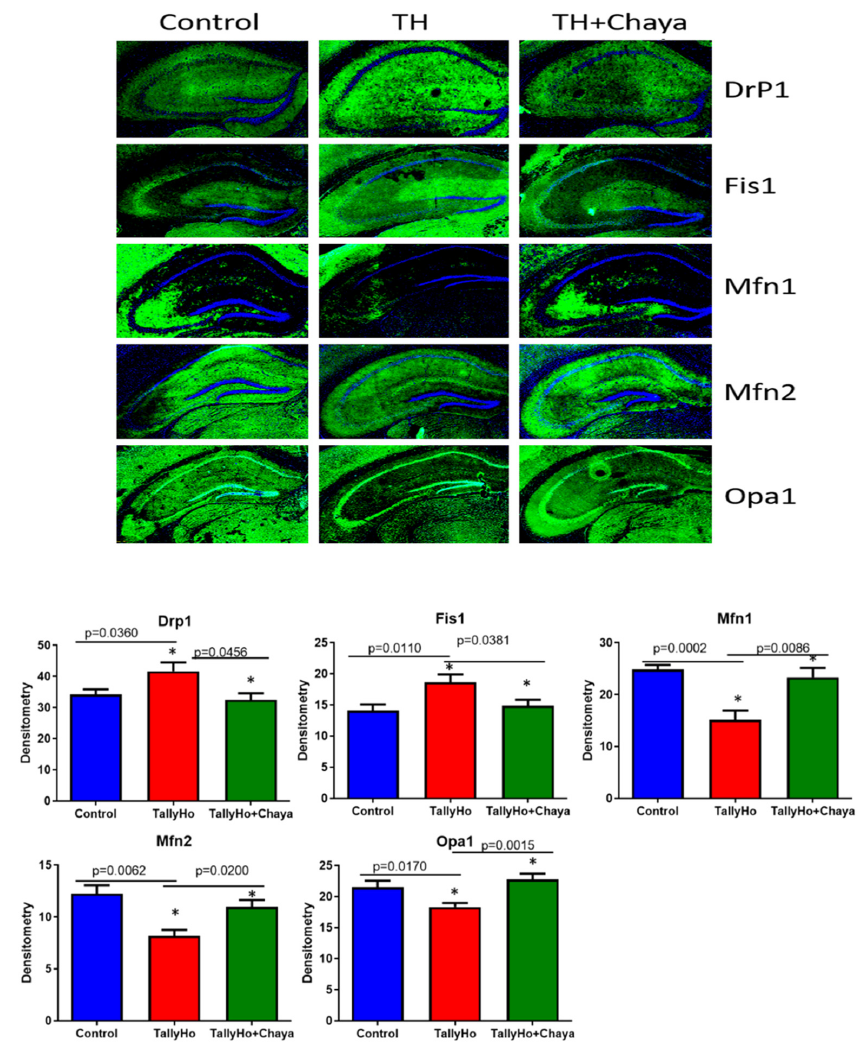
Figure 7. Immunofluorescence analysis of the hippocampal mitochondrial dynamic proteins of 14-month-old non-diabetic control mice, TH mice fed with chaya, and TH mice fed with regular chow. The TH + chaya mice showed significantly decreased levels of these proteins, which were increased in the TH mice (Drp1, p = 0.0456 and Fis1, p = 0.0381), and the TH + chaya mice showed significantly increased levels of these proteins, which were decreased in the TH mice (Mfn1, p = 0.0086; Mfn2, p = 0.0200; and Opa1, p = 0.0015). * p =